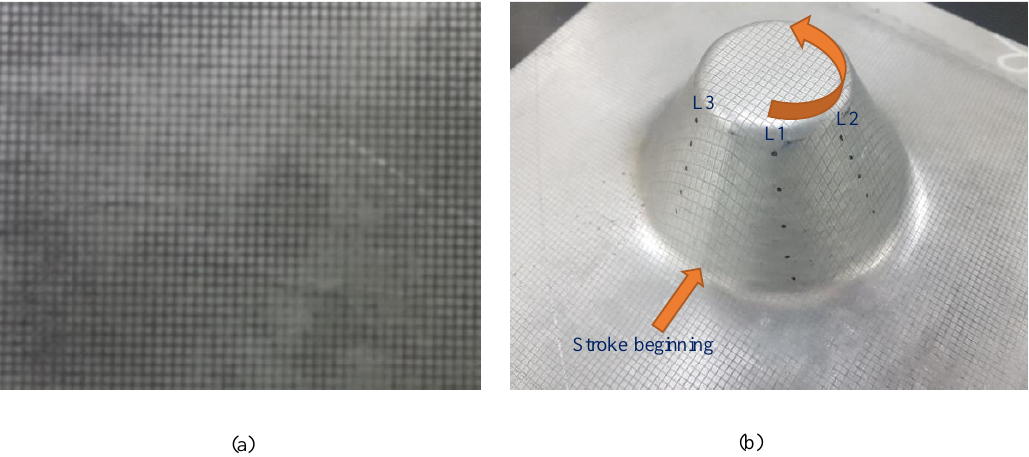
Figure 4. ( a ) Initial sheets etched with 2 mm square grid pattern; ( b ) sheet after deformation with measurement locations .